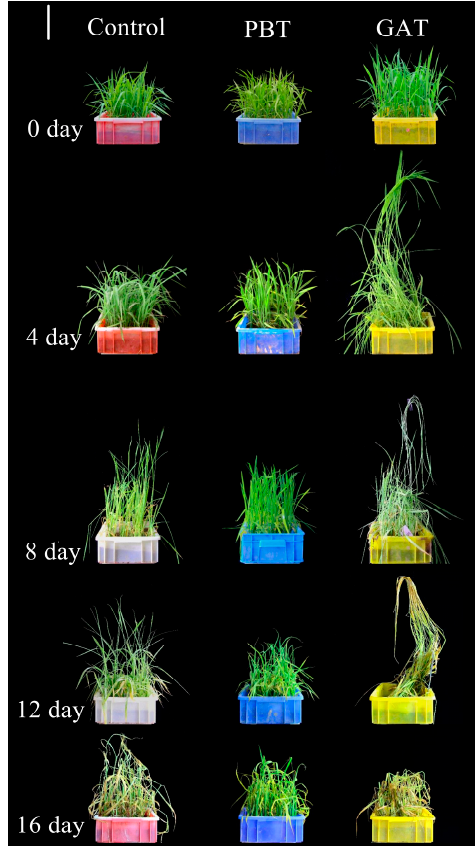
Figure 1. Phenotype of control, GAT (Gibberellin-treated) and PBT (paclobutrazol-treated) seedlings during submergence stress. The three columns show the control, GAT, and PBT seedlings, respectively. The five rows show seedlings that were submerged for 0, 4, 8, 12, and 16 days. Scale bar = 15 cm.